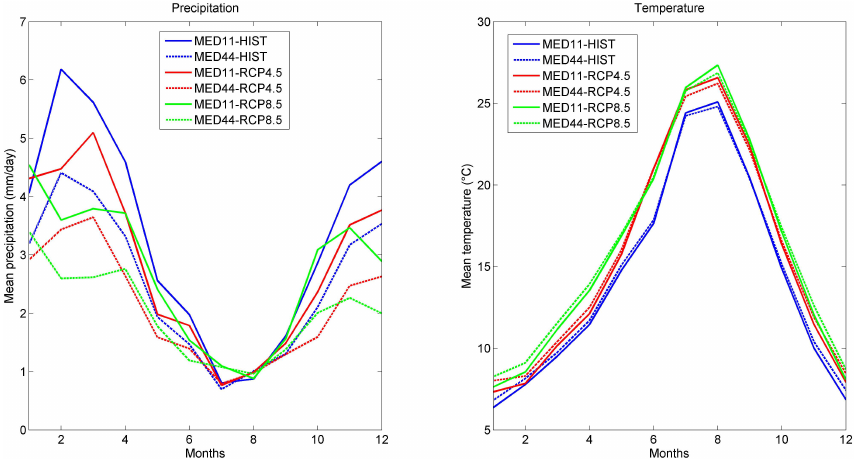
Fig. 8. Future changes on precipitation and temperature, with the RCP4.5 and RCP8.5 scenarios, between the historical period 1984–2005 and the projection period 2041–2062.